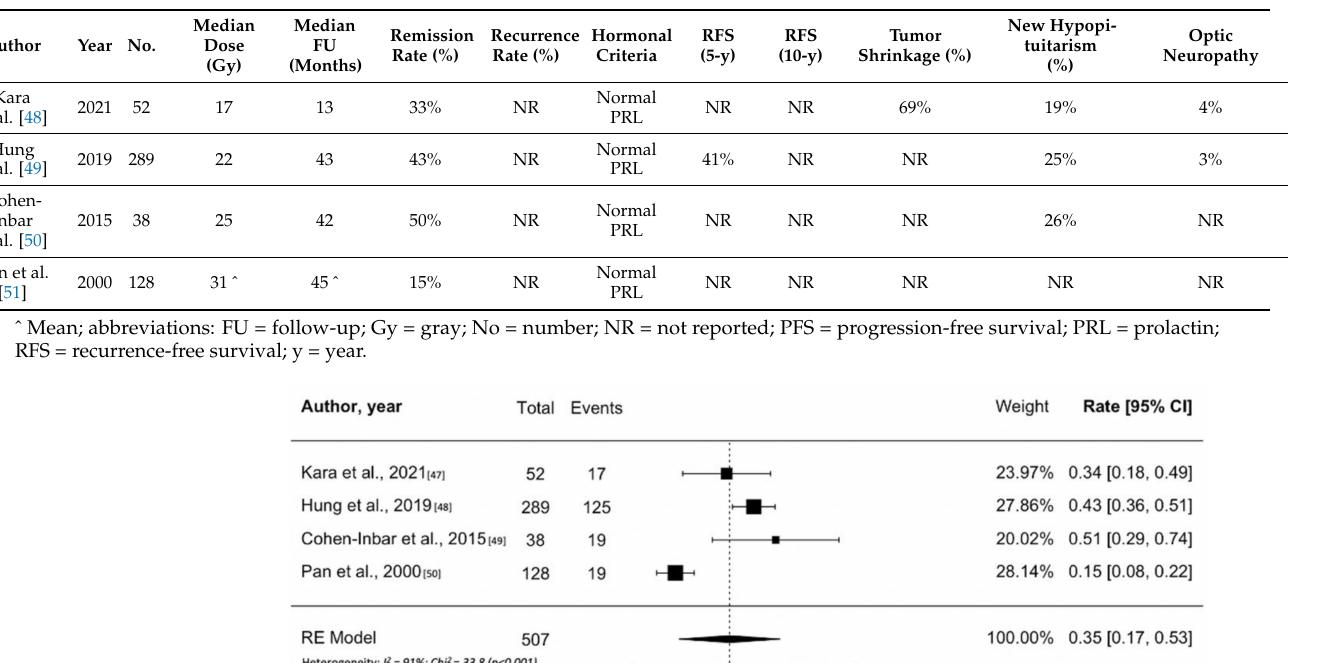
Table 4. PRL-secreting pituitary adenoma Gamma Knife treatment outcomes and toxicities.